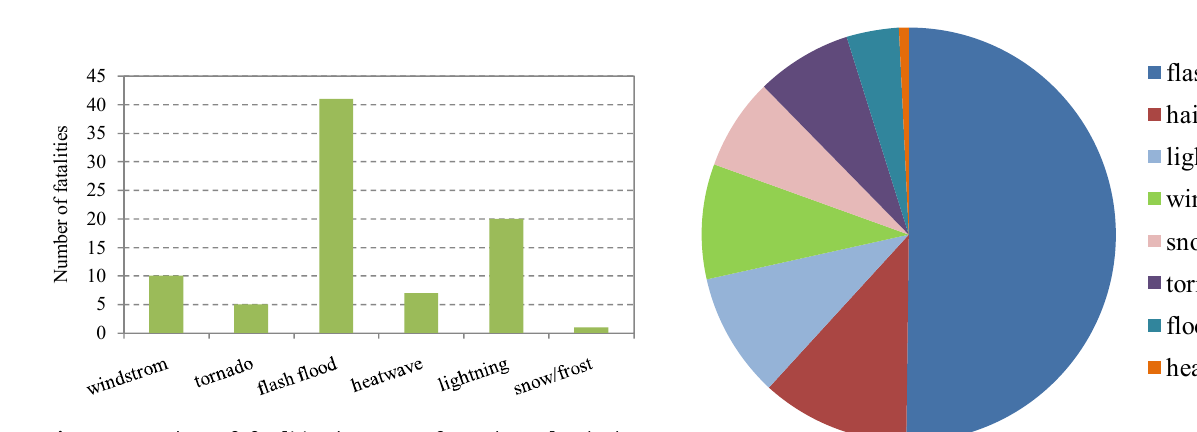
Fig. 5. Number of fatalities by type of weather-related phe- nomenon, for the period 2001–2011.